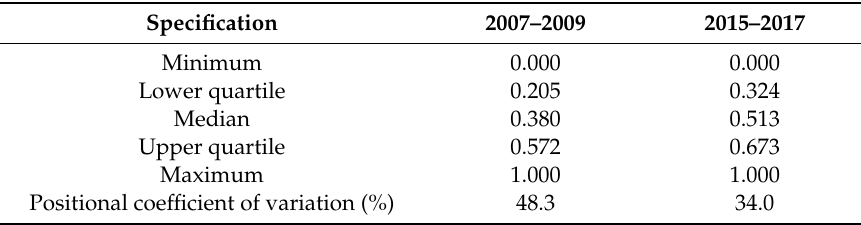
Table 3. Descriptive statistics of the synthetic indicator of the debt levels of Polish rural